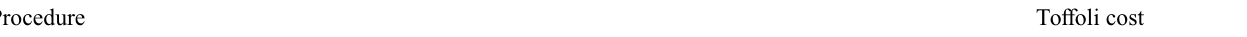
TABLE IV. The costs involved in the block encoding of the Hamiltonian for the interaction picture, following the same entries as in Table II. Procedure Toffoli